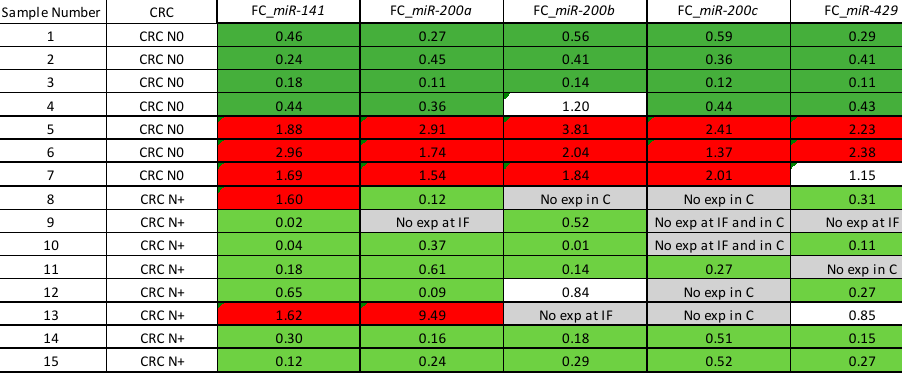
Figure 7. Heat-map of miR-200 family expression at the invasive front in comparison with central parts of the CRC. Legend: C, central part of the tumour; CRC, colorectal cancer; exp, expression; FC, fold change; IF invasive front; N0, without nodal metastases; N+, with nodal metastases.